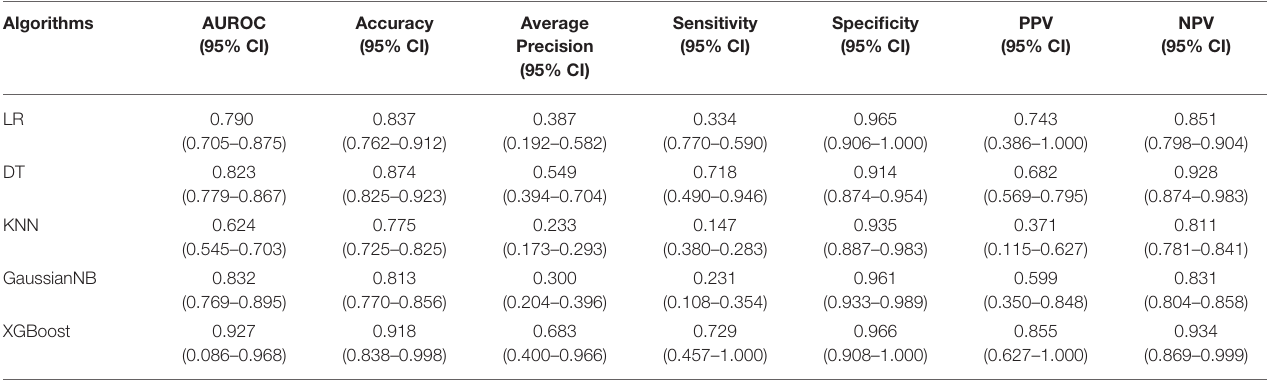
TABLE 2 | Performance comparison between the five models. Algorithms